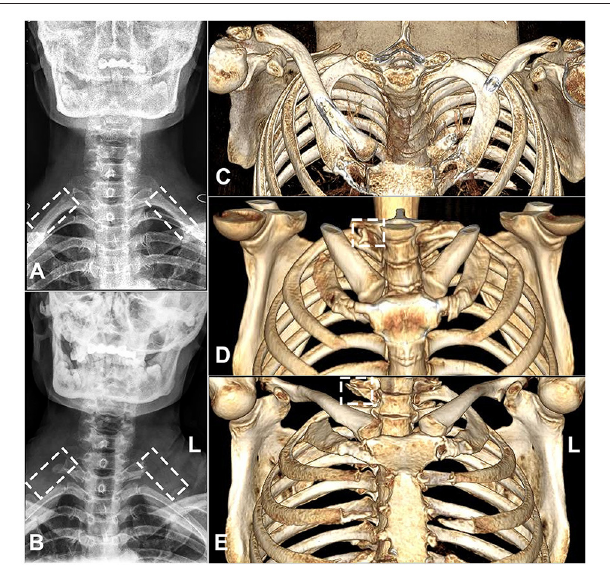
FIGURE 5 | Images of cervical fluoroscopy and a computed tomography scan of the first rib. (A) A representative image of preoperative cervical fluoroscopy of the involved first rib at the T1 level. (B) Postoperative cervical fluoroscopy image showing the bilateral removal of the proximal part of the first ribs (nearly up to their articulation) with transverse processes (represented by dashed rectangles). (C) A flat panel computed tomography 3D image showing a preoperative image of the first rib. (D) The posterior stump of the first rib (with an irregular surface) in the conventional surgery group (represented by a dashed square). (E) The posterior stump of the first rib (with a smooth surface) in the piezo surgery group (represented by a dashed square).